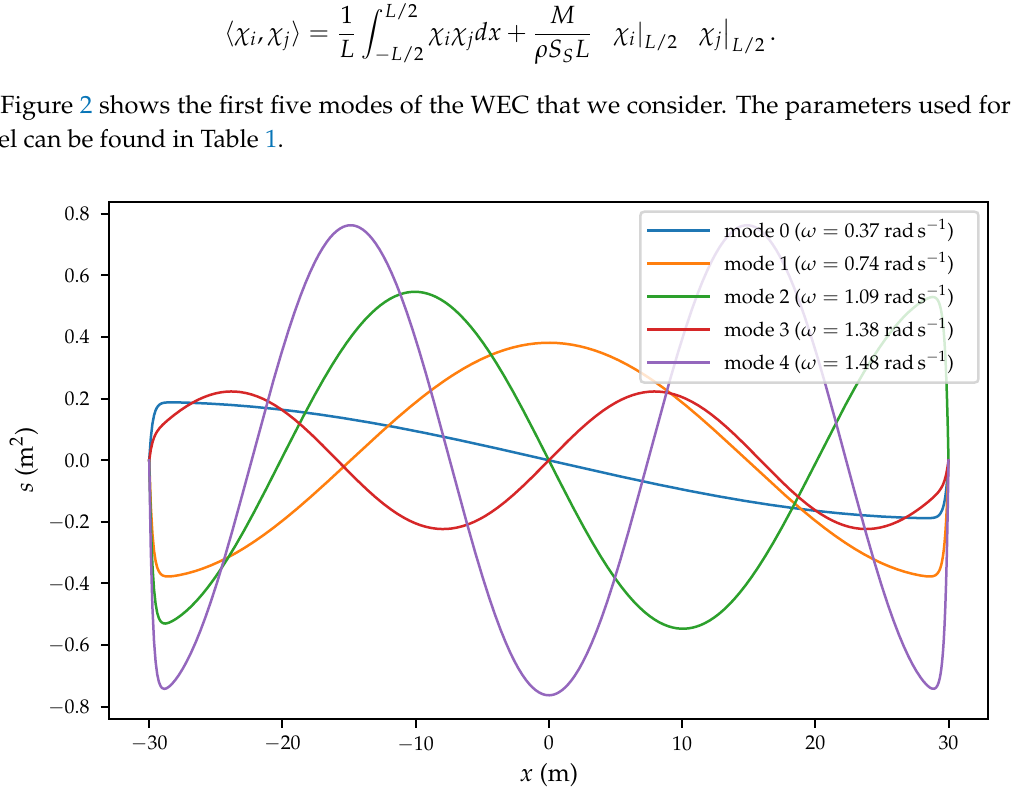
Figure 2. Deformation of the first five modes plotted in terms of the cross section s introduced in Equation (12) for the parameters given in Table 1. The modes are normalized using the scalar product